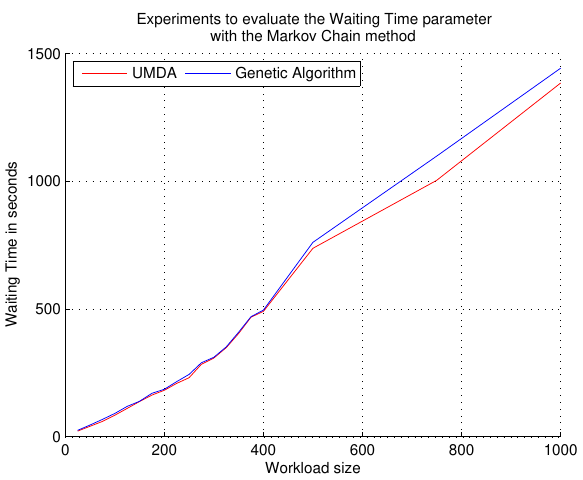
Figure 6. Results of evaluating the waiting time parameter with the Markov chain